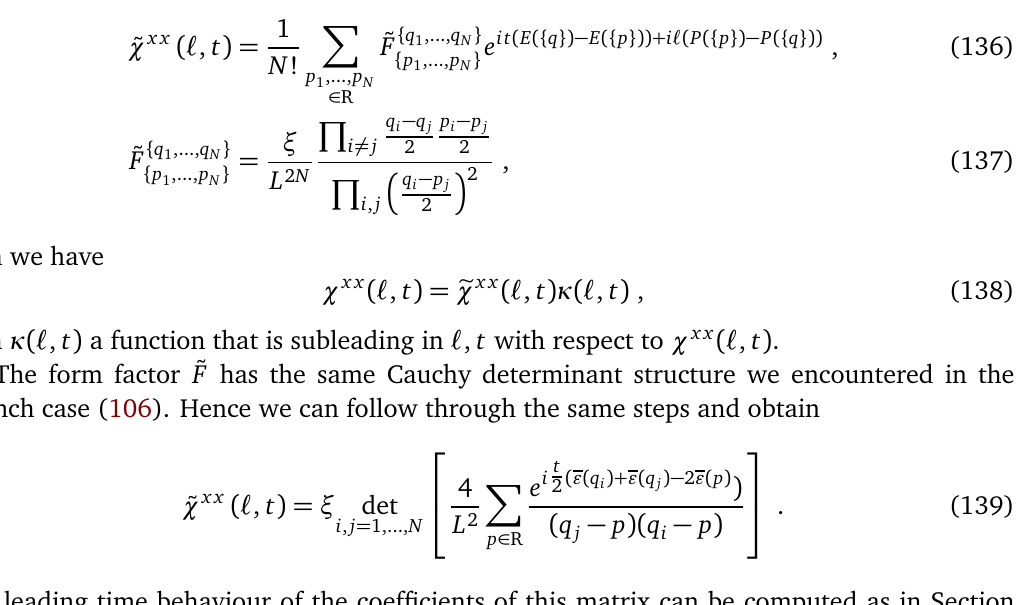
Figure 10: Left: Numerical results for 〈 σ x function of t for a quench from h = 0.0218. The prefactor at order O ( ρ 2 sity ρ Q seen to be compatible with our numerical results. For comparison we also show (cid:198) ( ∞ ) = 0.96525. Right: Numerically determined (red) and calculated leading C x FF order (blue) prefactor (96) divided by function of h . Because of the oscillations, the measured value is an average of six points between times t = 75 and